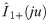
Validation of Eq (40).Absolute value of I^1+(ju) on top and relative error in log10 scale on bottom obtained from the approximate expression of I^1+(ju) given by Eq (40) while substituting the exact expression of V^1d(w) and performing the numerical PV integration. Test cases are relative to different sets of parameters [Φa, Φb, φo], where φ = Φa and φ = −Φb are the azimuthal directions of the PEC faces of the wedge and φ = φo is the azimuthal direction of the incident Ez-polarized plane wave.